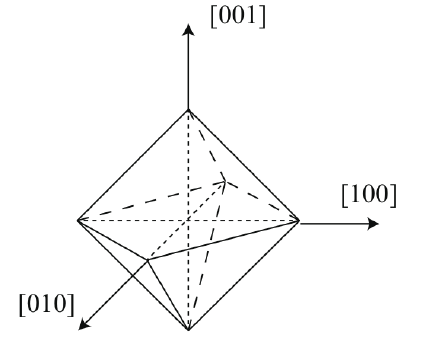
Figure 3. Regular octahedral